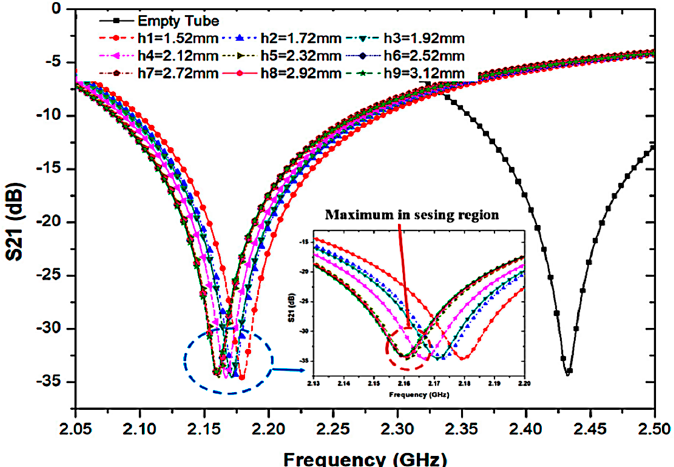
Figure 9. Simulated frequency shift at different volume levels of the sensing area using distilled water filled in the PP tube. water filled in the PP